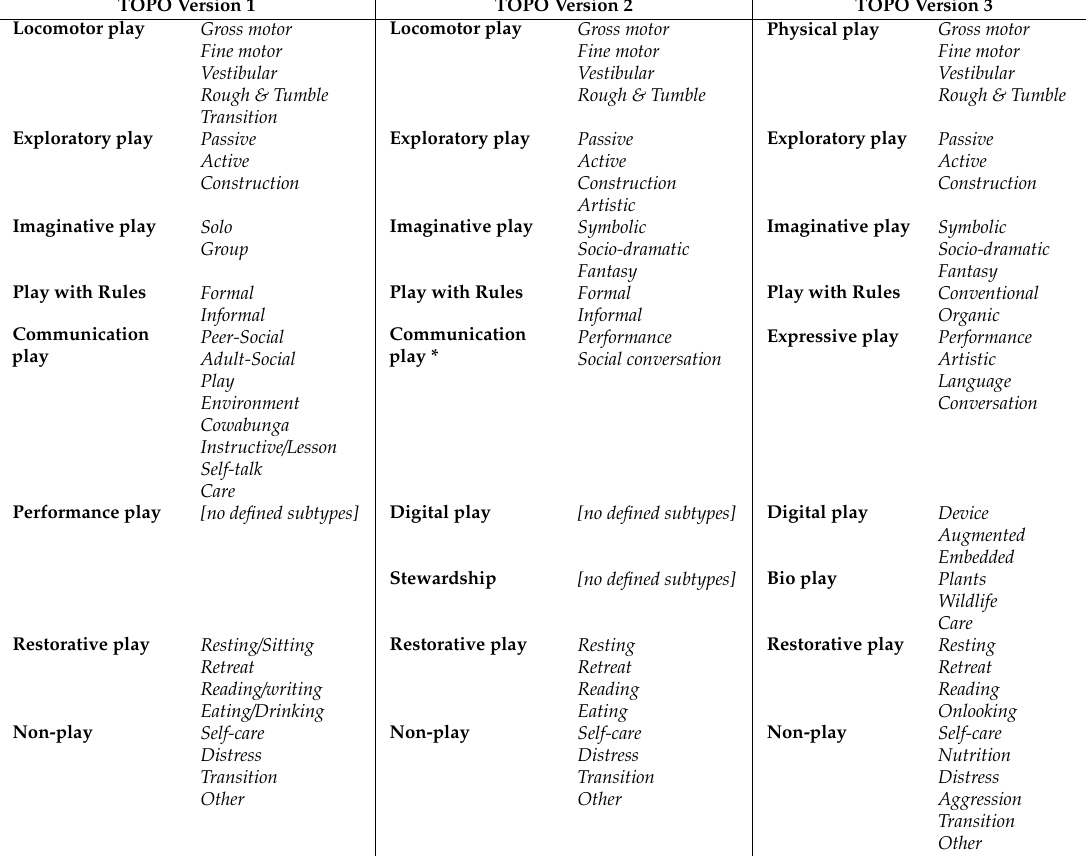
Table 2. Iterations of the Tool for Observing Play Outdoors